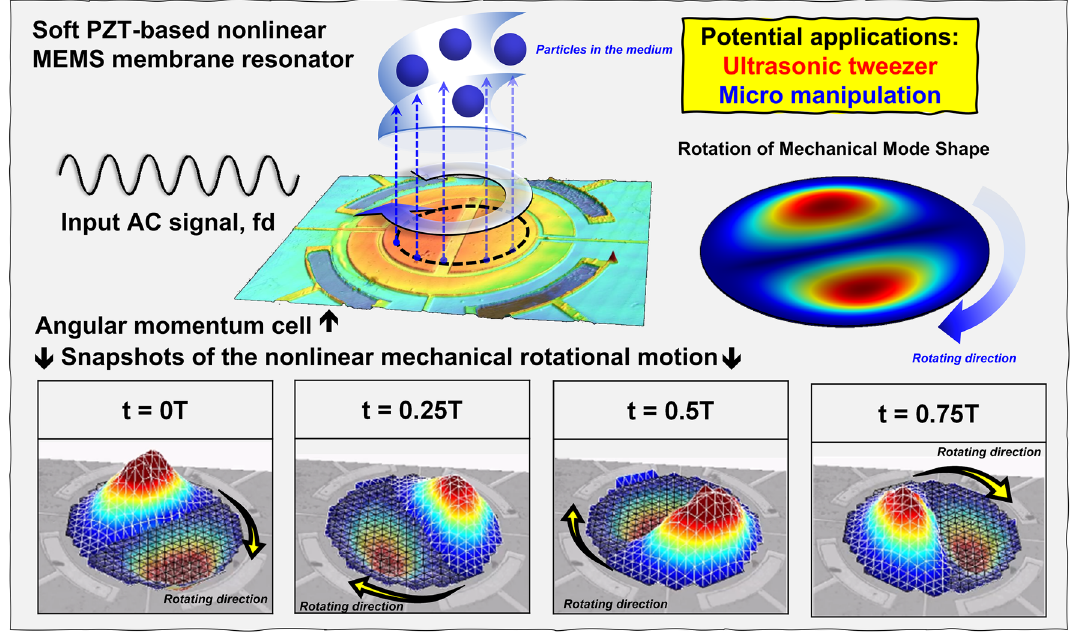
Figure 1. Schematic of the proposed piezoelectric nonlinear MEMS resonator-based angular momentum cell: A CMOS-compatible input electrical signal is applied to the piezoelectric device and triggers the mechanical rotation motion. To identify the real-time motion, snapshots of the clockwise rotation motion are